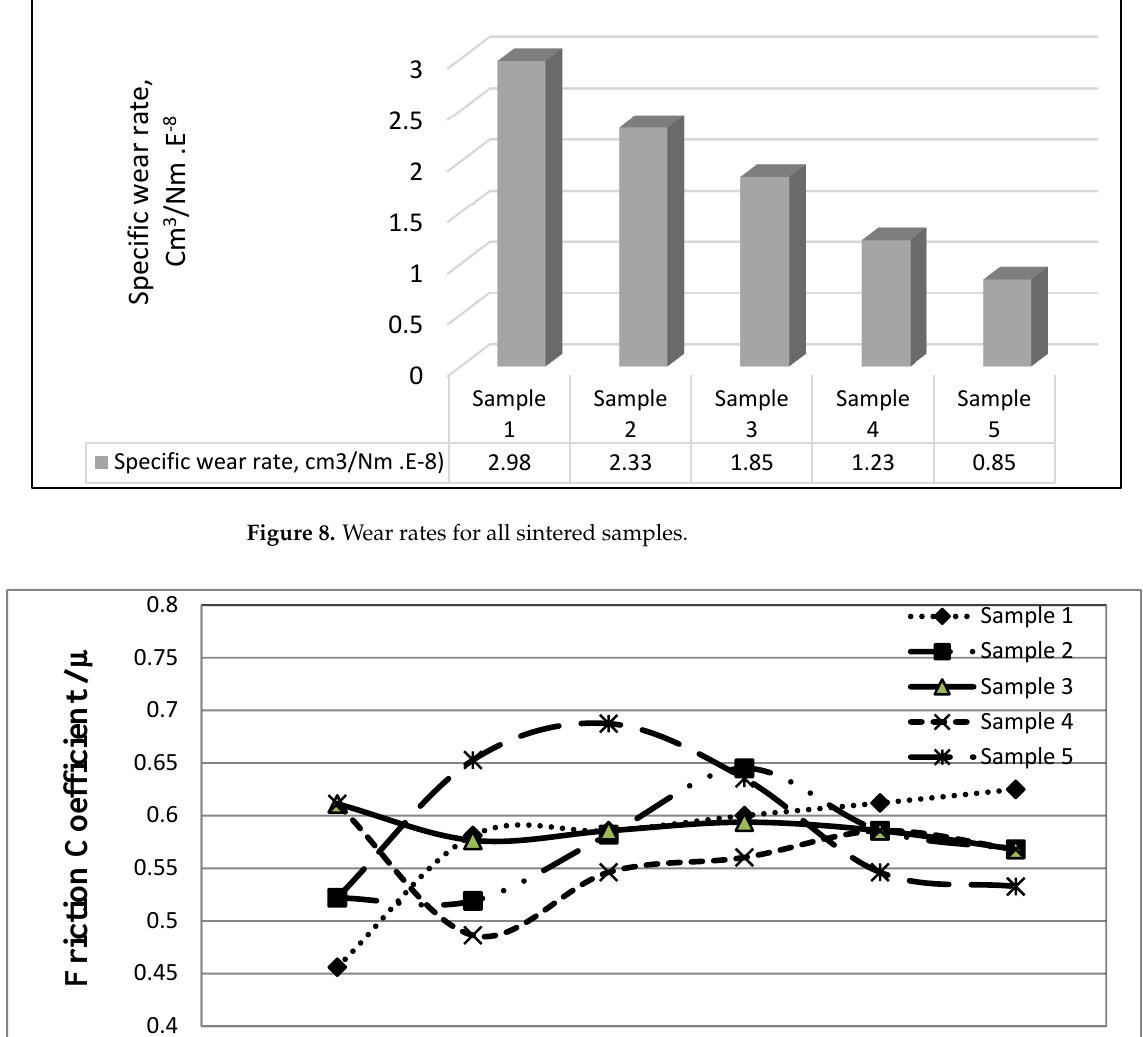
Figure 8. Wear rates for all sintered samples.